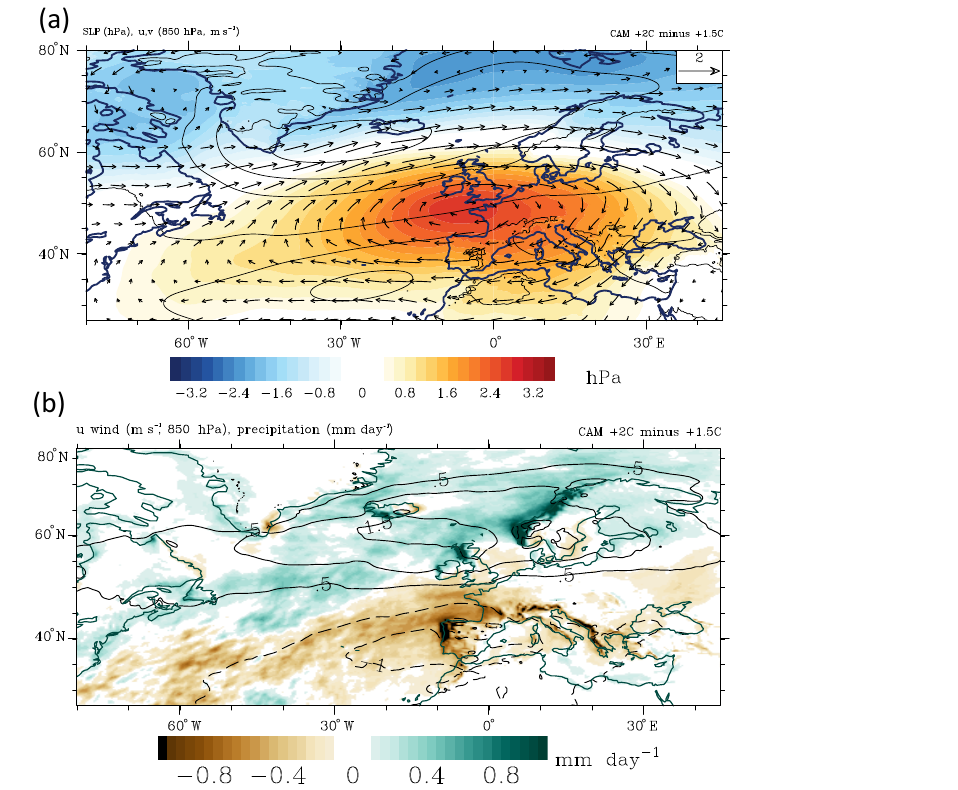
Figure 5. Difference between + 2 and 1.5 ◦ C ensembles in DJF (a) sea level pressure (shaded, hPa) and wind vector at 850hPa (ms − 1 ). Contours show (as in Fig. 4a) DJF sea level pressure in the present climate, with a local maximum in the vicinity of the Azores and minimum in the vicinity of Iceland; (b) precipitation (mmday − 1 ) and zonal wind (contours, ms − 1 ) in